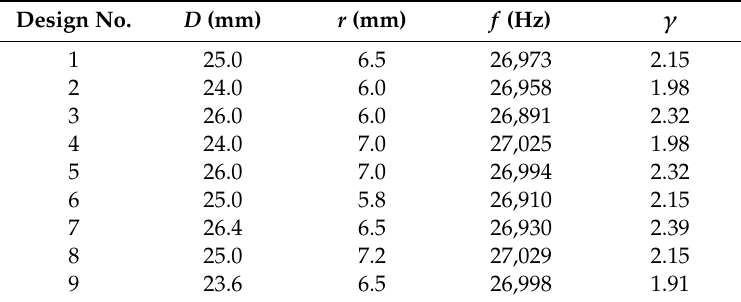
Table A1. CCD design table and the relevant FE analysis results (Type 1). Design No.